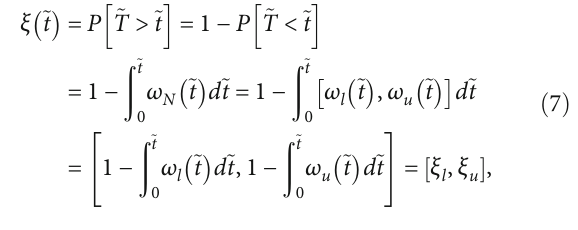
= ½ 0, 0 : 3 (cid:2) n